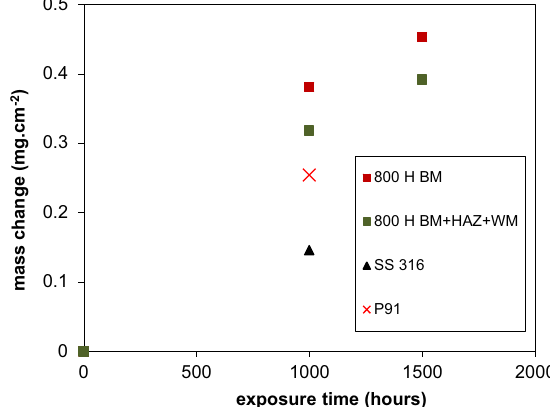
Fig. 4. Mass change of the specimens of alloys exposed in impure helium environment at 750 – 760 ° C. BM: base metal, WM: weld metal, HAZ: heat affected